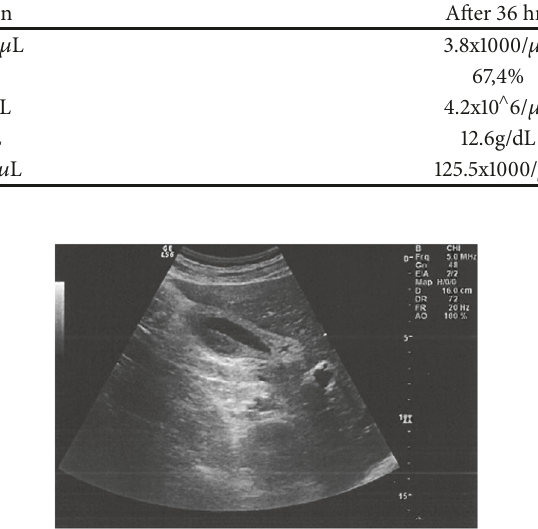
Figure 1: Abdominal ultrasound showing pericholecystic fluid collection, large free fluid at Douglas’s pouch, and right paracolic gutter.